Question: Produce a descriptive caption suitable for publication.
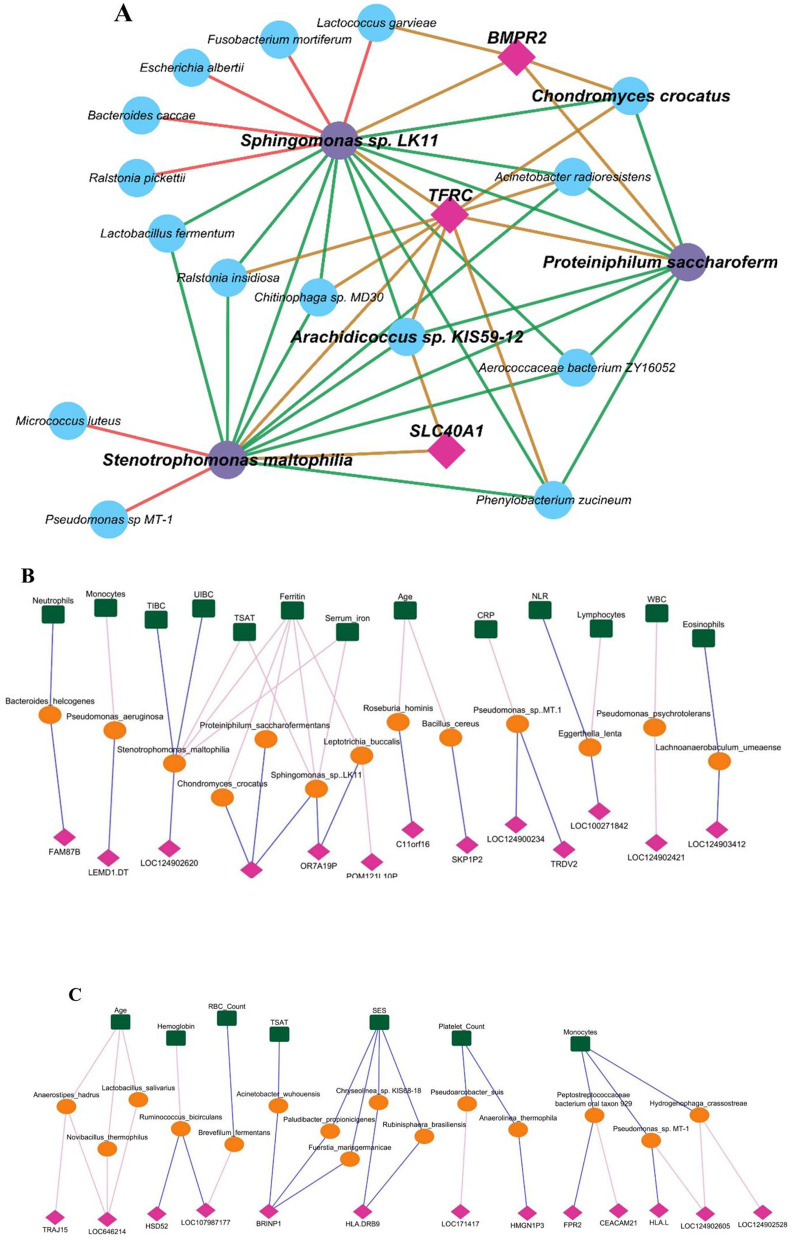
Answer: Integrated host–microbe–hematological interaction networks. (A) Microbial–microbial and microbe–gene associations. Pink diamonds represent host genes; purple circles denote microbial hub taxa; blue circles represent other taxa. Brown edges indicate gene–microbe correlations; green edges denote multi-edge microbe–microbe interactions; red edges denote single interactions. (B, C) Correlation networks integrating hematological parameters (green squares), microbial taxa (orange circles), and host genes (pink diamonds) in (B) IDA and (C) controls. Blue edges indicate positive correlations; pink edges indicate negative correlations.